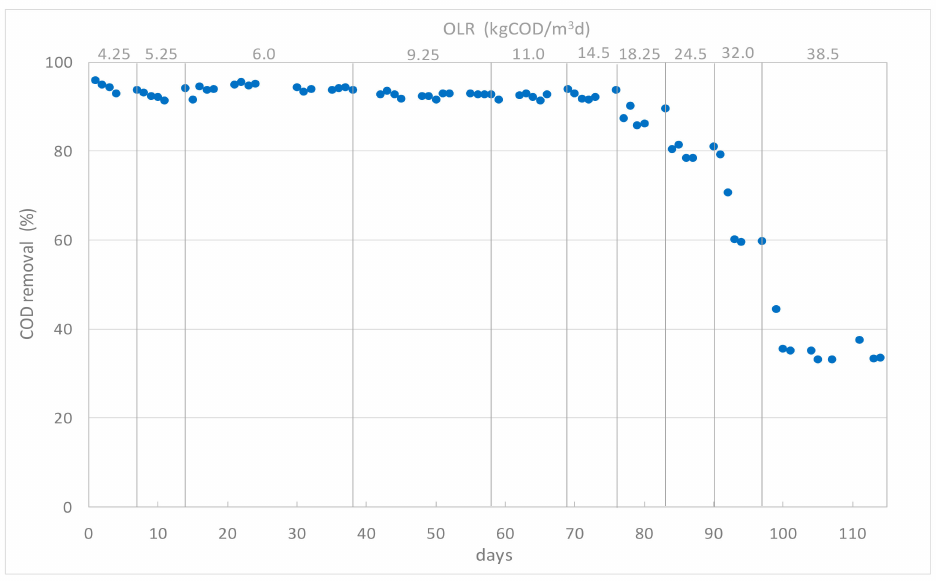
Figure 2. Chemical oxygen demand (COD) removal over the pilot plant operational